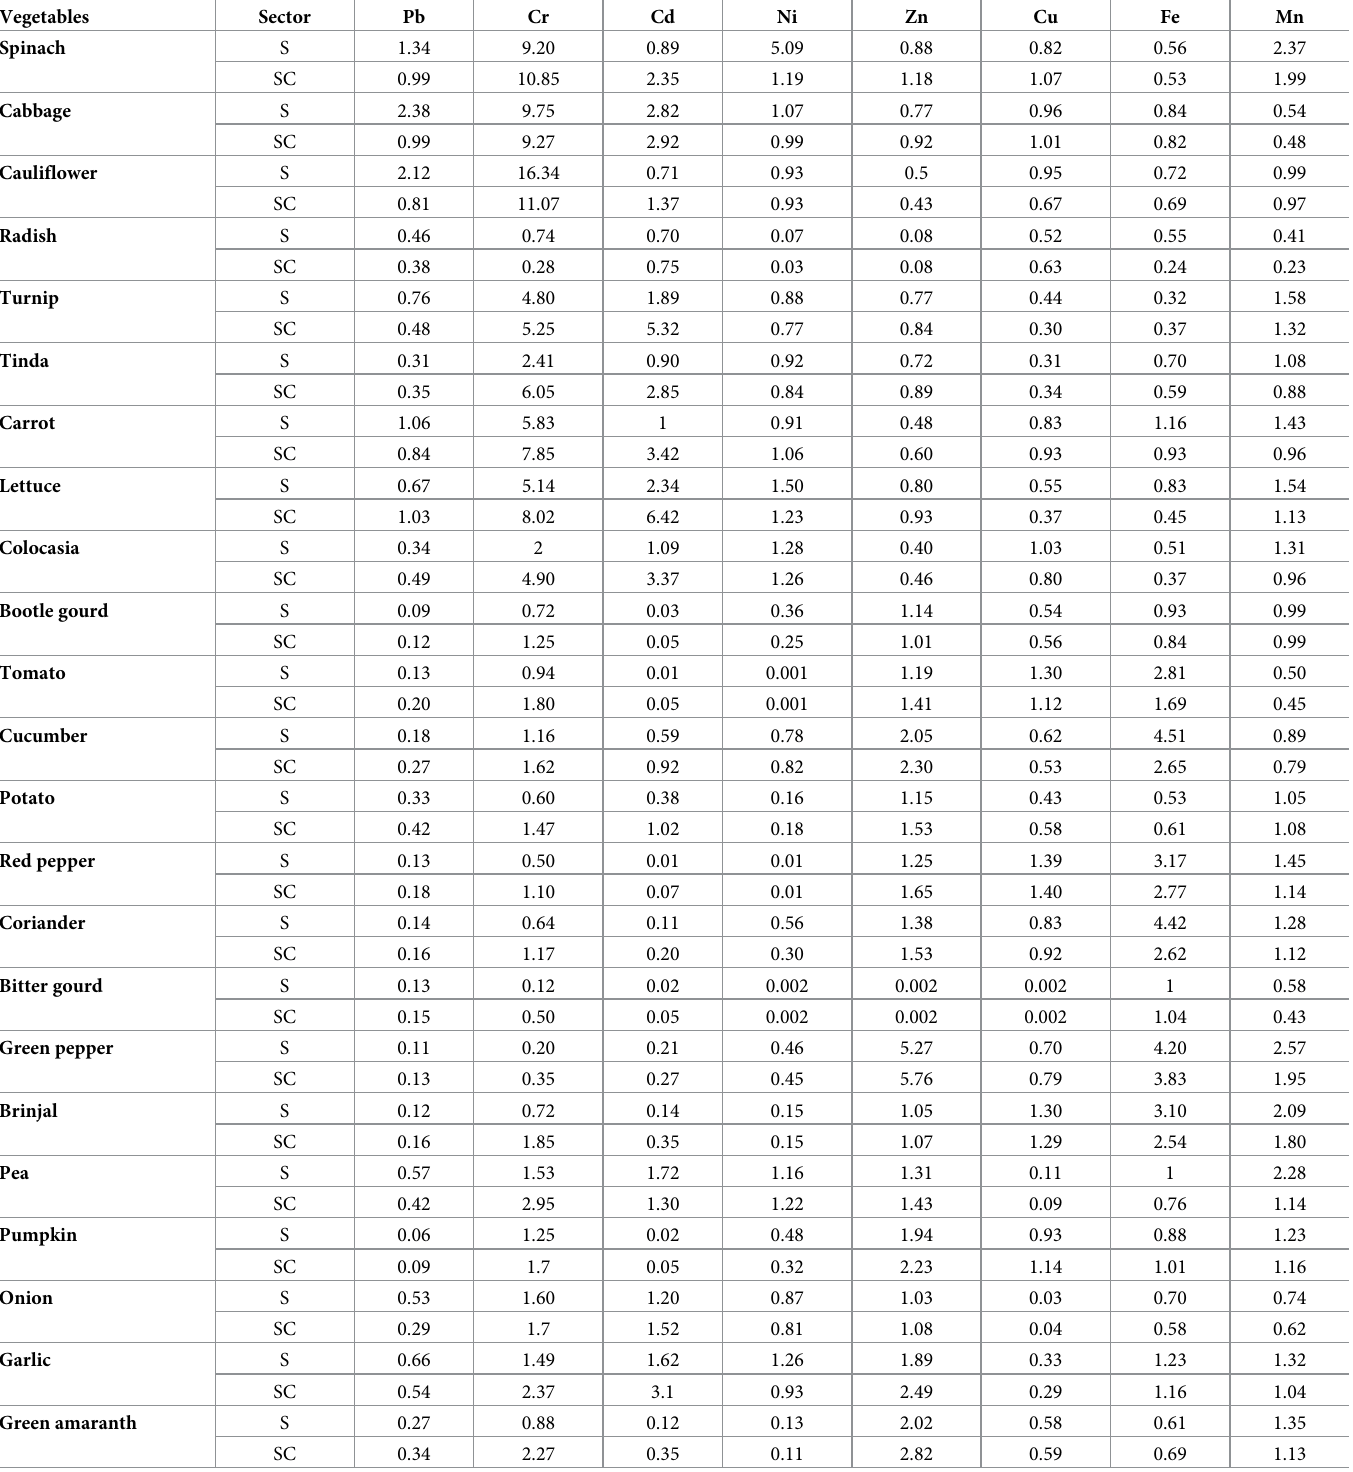
Table 5. Heavy metals transfer factor for vegetables grown in Swabi. Vegetables Spinach